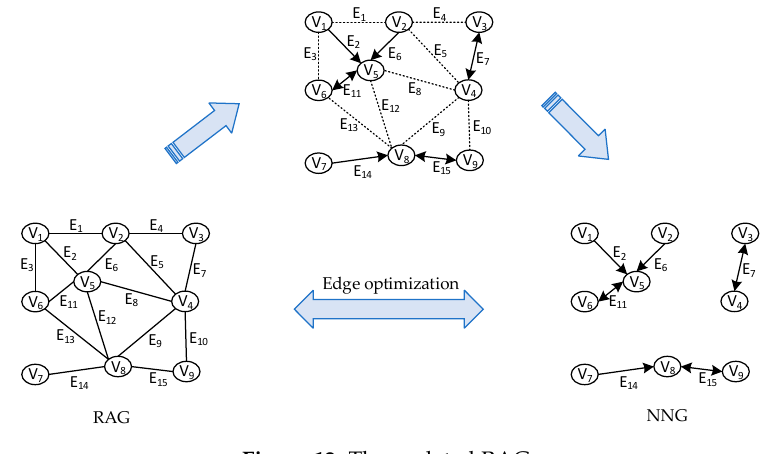
Figure 12. The updated RAG.